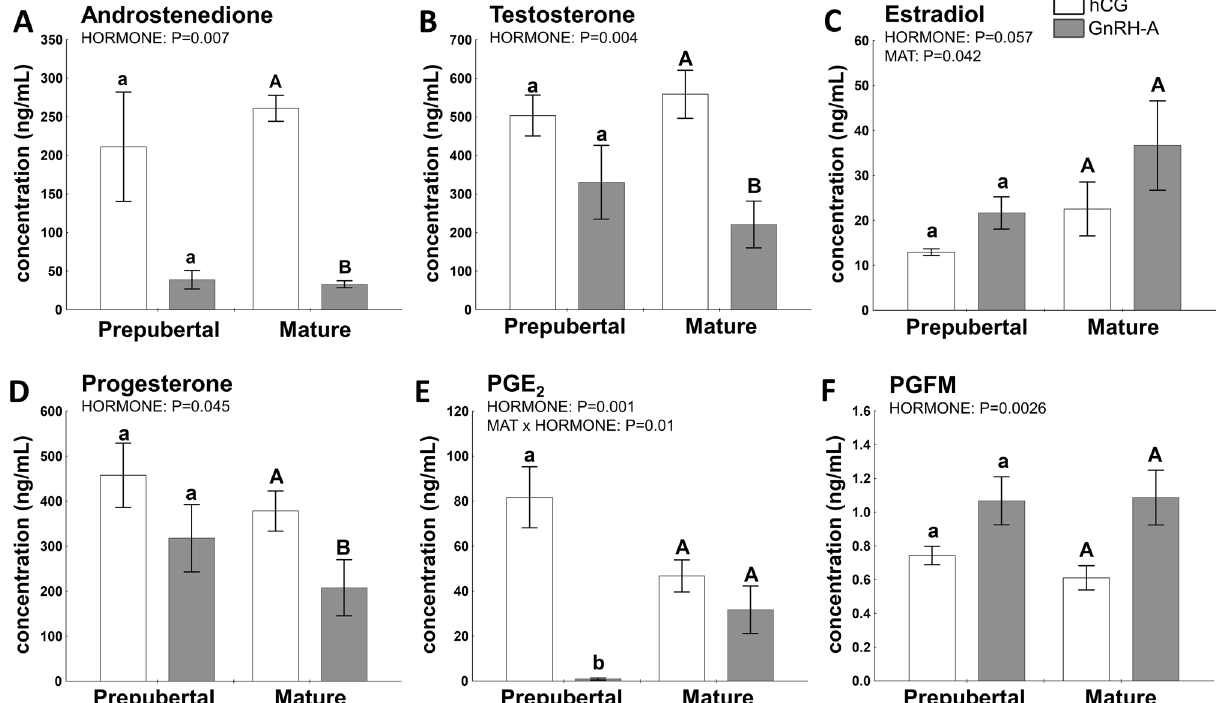
Figure 1. Hormonal milieu of the follicular fluid is affected by either sexual maturity status (prepuberty or maturity; MAT) or hormonal (hCG and GnRH-A; HORMONE) treatment in gilts. The follicular fluid A 4 ( A ), T ( B ), E 2 ( C ), P 4 ( D ), PGE 2 , ( E ) and PGFM ( F ) is shown for prepubertal and mature gilts. Data are presented as mean ± SEM (n = 5–6 per group). Data were analyzed using two-way ANOVA and Tukey post-hoc test. Means with different superscripts differ significantly (small letters—prepubertal gilts, capital letters—mature gilts; P < Sexual maturity did not affect LHCGR mRNA in follicles (Supplementary Fig. 2A), but it affected its protein levels ( P = 0.041; Supplementary Fig. 2) in the follicular walls of hCG- and GnRH-A-treated gilts. Interestingly, abundance of LHCGR was positively correlated with follicular E 2 level for both mRNA (r = 0.611, P = 0.016) and protein (r = 0.7359, P = 0.003). In addition, the LHCGR protein correlated with other proteins tested: PTGFS (r = 0.4767; P = 0.045) and ATF4 (r = − 0.4270; P = 0.4362). For FSHR mRNA abundance, only a tendency was noticed for HORMONE ( P = 0.06; Supplementary Fig. 2B), while it reached significance for protein ( P = 0.02; Supplementary Fig. 2D). In addition, FSHR protein was nega- tively correlated with PTGFS protein abundance (r = − 0.554; P = 0.021). Factors related to production and action of PGs. PGs play a crucial role in the development and ovulation of preovulatory follicles 18,20 . Thus, both mRNA and protein abundance of the selected components of the PGE 2 and in the conversion of arachidonic acid to prostaglandin H2 (PGH2), which is next converted to PGE 2 and PGF 2α or prostacyclin and thromboxane. Sexual maturity affected mRNA abundance of PTGS2 in the follicular walls (Fig. 3C). However, hormonal treatment strongly affected PTGFS protein expression ( P = 0.018; MAT × HOR- MONE interaction, P = 0.009; Fig. 3D). Interestingly, a 2.5-fold higher abundance of the PTGFS protein was indicated in prepubertal gilts challenged with GnRH-A compared with mature counterparts ( P = 0.029). It was also significantly increased when compared to hCG-treated prepubertal gilts ( P = 0.0096). A negative correlation